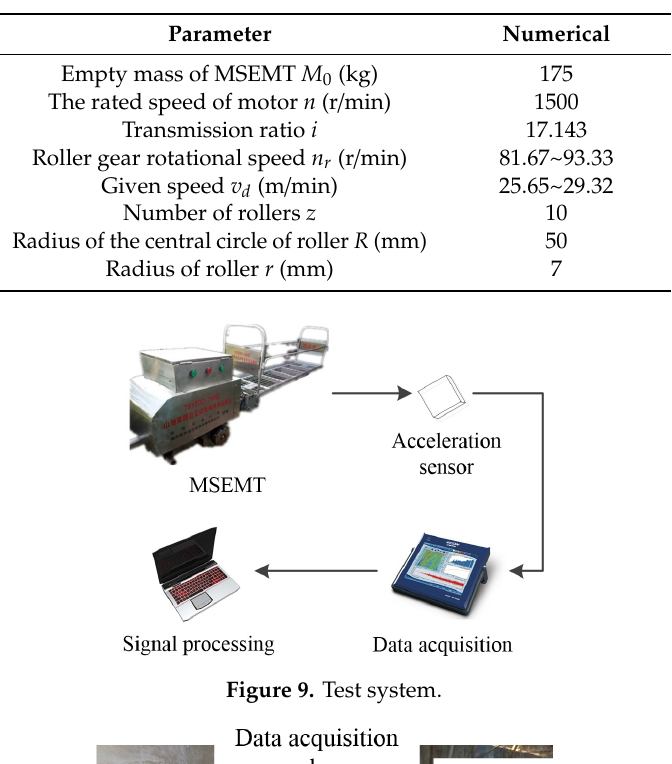
Table 2. Parameters of the MSEMT.